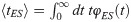
Frequency spectra of the product number and the product creation rate for two enzymatic reaction models.(A) A multi-enzyme reaction scheme for product creation. Individual reaction processes of N identical enzymes are independent of each other. A bimolecular enzyme-substrate association occurs at a rate of k1[S] with [S] denoting the substrate concentration. φES(t) represents the lifetime distribution of an enzyme-substrate complex (ES), which is modeled as a gamma distribution, i.e. φES(t) = ta−1e−t/b/Γ(a)ba. p2,−1 are the probabilities associated to catalytic reaction and enzyme-substrate dissociation. (inset) φES(t) for various values of a. 〈tES〉 is the mean lifetime of an ES complex defined by 〈tES〉=∫0∞dttφES(t). (B-C) Theoretical predictions (solid lines) and simulation results (circles) for the FSPN and FSRR for Scheme a with k1〈tES〉[S] = 1 and p2 = p−1 = 1/2. The number of single enzymes is 10. Different colors indicate different values of a. (D) A vibrant catalytic reaction scheme for product creation by a single enzyme. The catalytic reaction is set to be the rate determining step in Scheme A, so that the entire enzymatic reaction rate can be represented by the catalytic reaction rate, R(Γ). The fluctuation of R(Γ) due to coupling with a hidden variable, Γ, is modeled as an exponential model, R(Γ) = k0e−αΓ. (inset) The time correlation function of Γ, which is here modelled as an Ornstein-Uhlenbeck process. The fluctuation rate of Γ is given by λ. (E-F) Theoretical predictions (solid lines) and simulation results (circles) for the FSPN and FSRR for Scheme D for various values of λ. The value of k0/κ0 is chosen to be 0.64. The product decay process is a simple Poisson process. The value of γ is given by γ〈tES〉 = 5 in (B) and γ = 5k0 in (C). For more detailed information about the models and simulation method, see Methods.